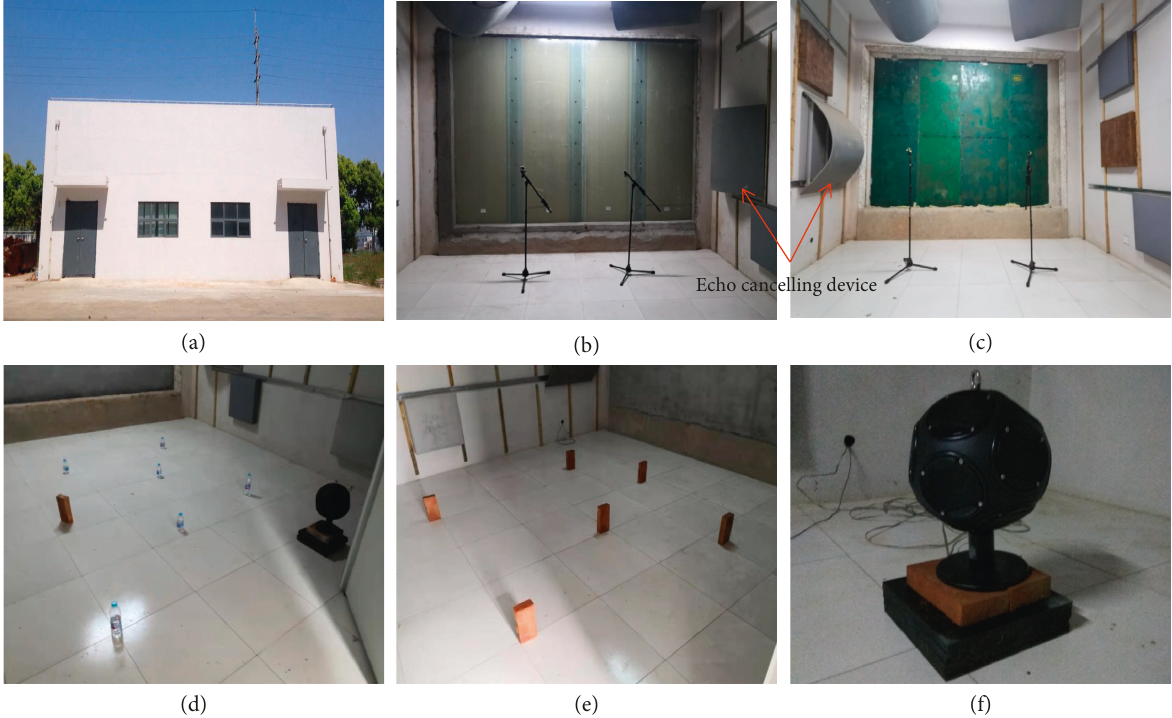
Figure 3: The laboratory: (a) external structure of the laboratory; (b) sound source room and specimen assembly drawing; (c) receiving room and specimen assembly drawing; (d) layout of measurement points in sound source room; (e) layout of measurement points in receiving room; and (f) placement of sound source.